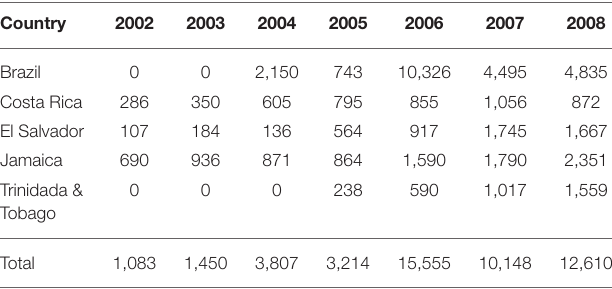
TABLE 2 | U.S. bioethanol imports from select countries in caribbean and central America ($1,000) (International Energy Agency, 2016).